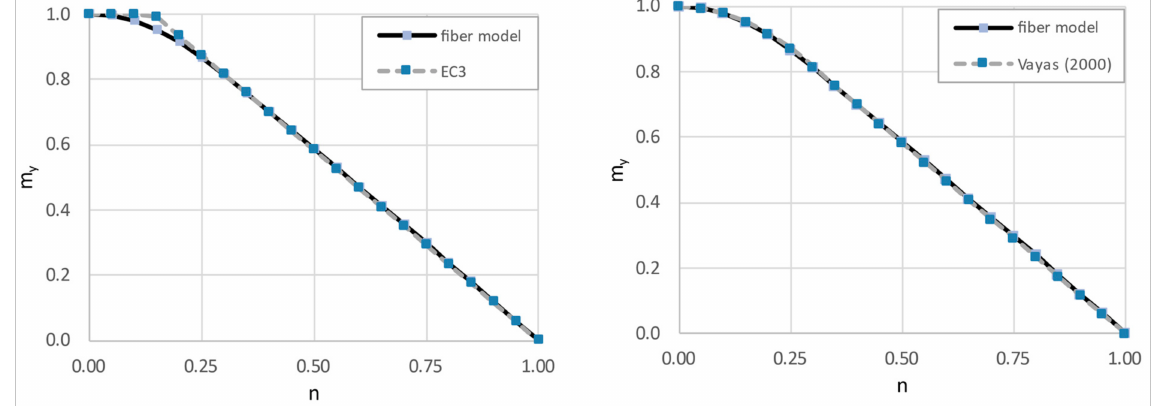
Figure 2. Comparison of interaction resistance diagrams n + m y of numerical analysis (fiber model) and analytic formulae EC3 [1], Vayas (2000) [26] for a HEB 450